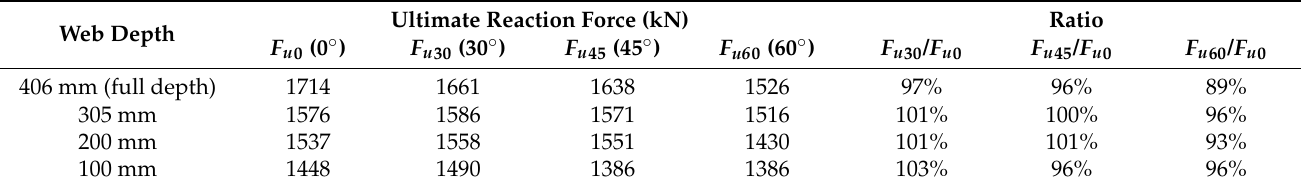
Table 2. Effect of varying beam web height.